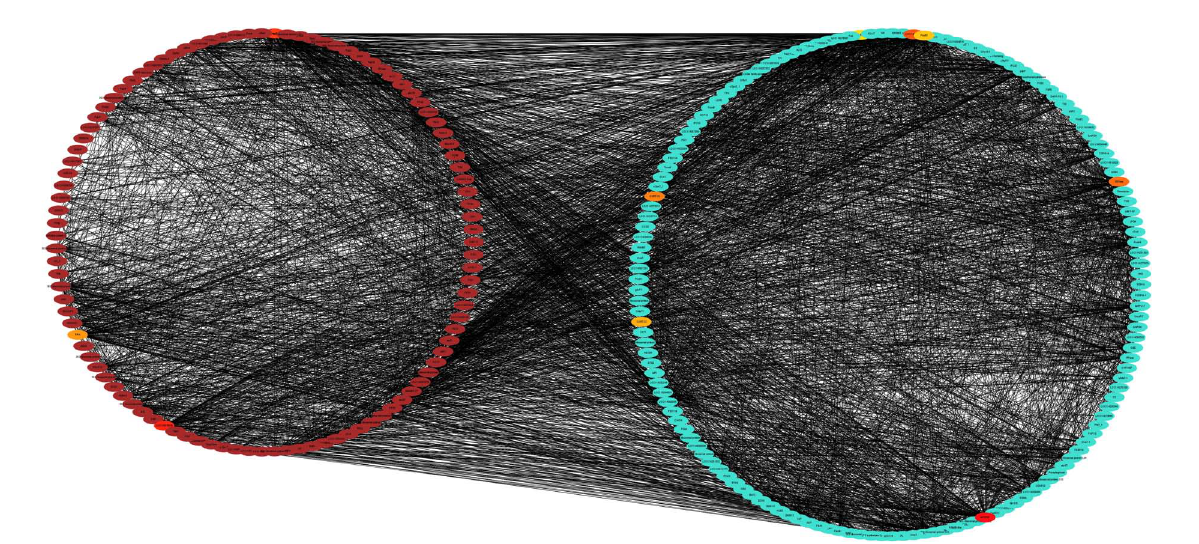
FIGURE10 Protein-Protein Interaction network analysis of drought-responsive modules. PPI networks of the positively correlated brown module and the negatively correlated turquoise module were visualized using the Cytoscape software platform. The correlation networks of the top 10 genes and their directly regulatory genes from brown and turquoise modules were clustered into two circles. The color depth of 10 hub genes represents the strength of connectivity.